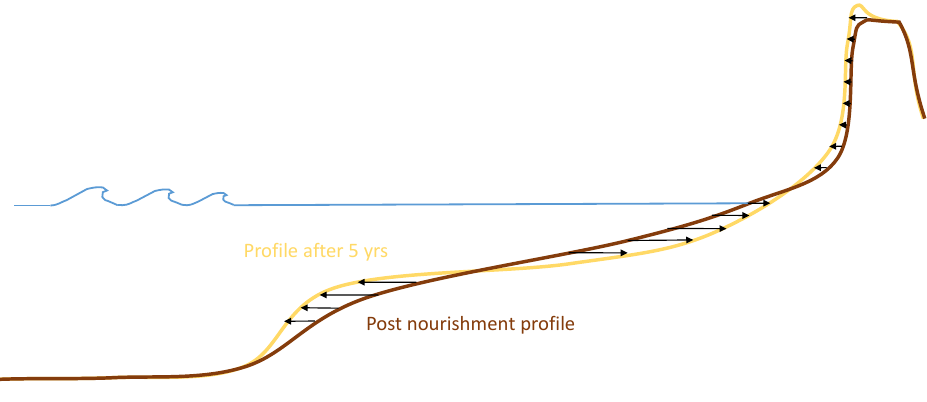
Figure 14. Schematic view of observed cross-shore behavior at the Hondsbossche Dunes nourishment including an increase in dune volume and equilibration of beach width, modified from